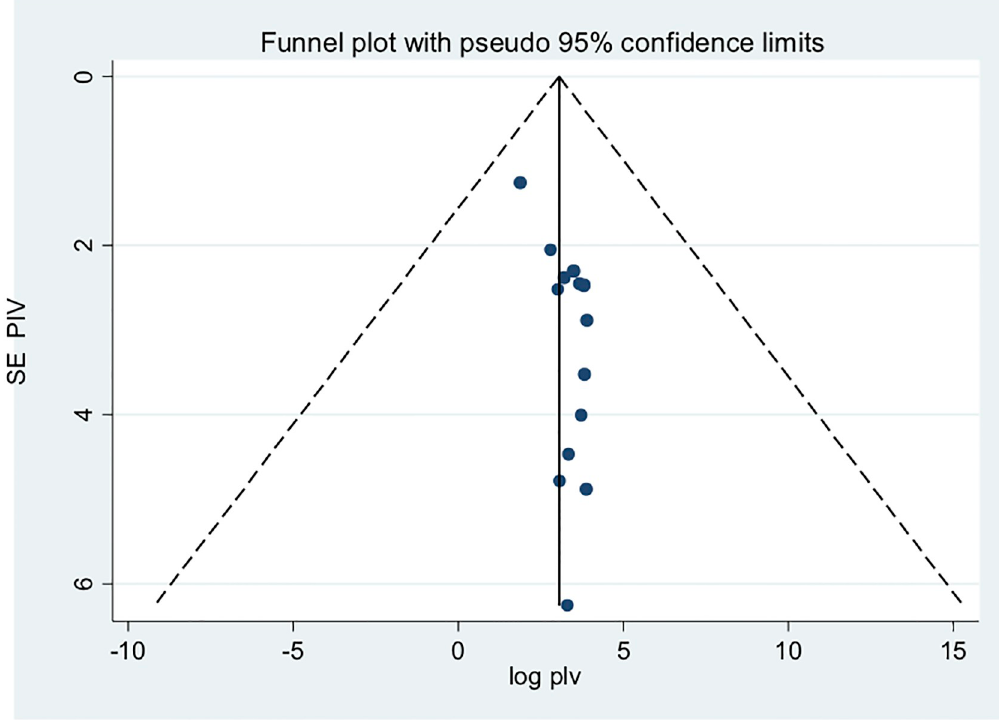
Fig 2. Funnel plot for systematic review of the prevalence of depression among epileptic patients, 2005–2017 in sub- Saharan